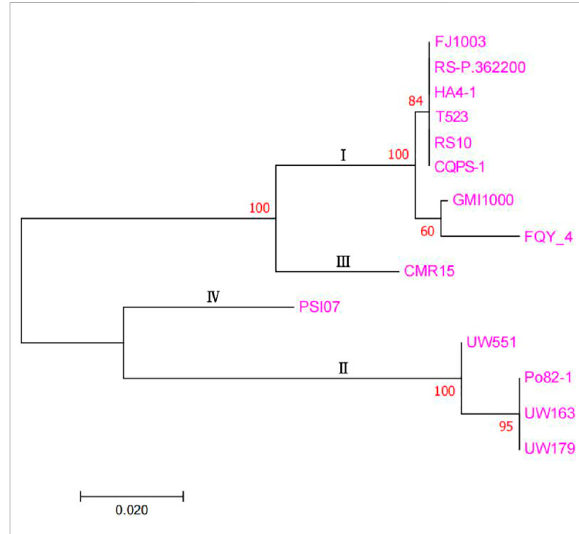
FIGURE 4 Molecular phylogenetic analysis between FJ1003 and other strains. This fi gure is mainly based on the sequence similarity of endoglucanase in different genomes. The percentage of tree in which the associated taxa were clustered together, is shown next to the branches. The tree is drawn to scale, with the corresponding branch lengths indicating the number of substitutions per site. The pink font on the far right is the name of the different species of R. solanacearum